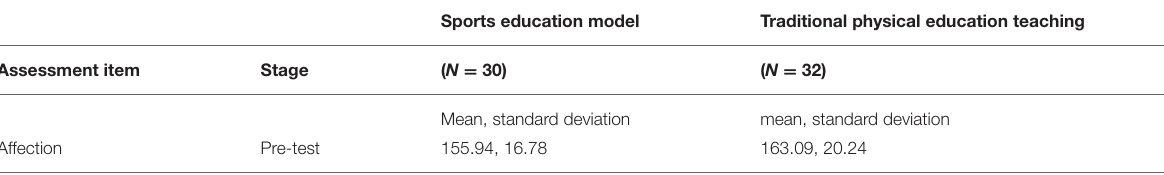
TABLE 7 | Homogeneity test of the affective effect pre-test comparing the two teaching groups.